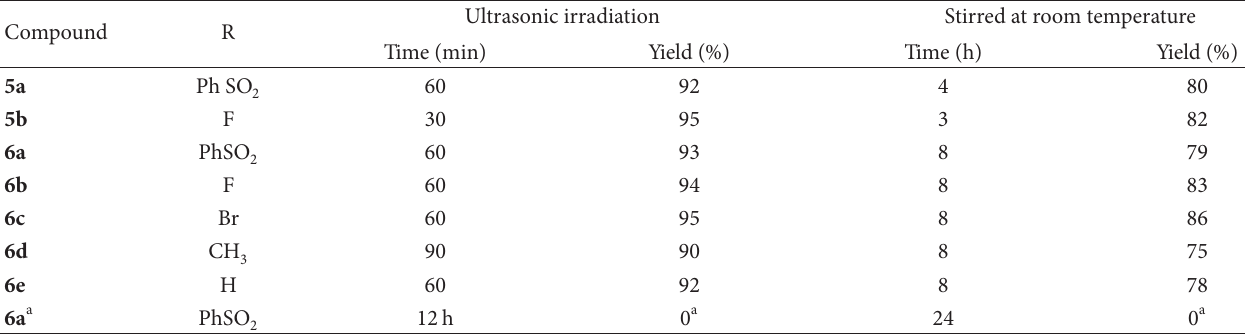
T 2: Synthesis of 2-bromo-1-substituted ethanones 5a,b by bromination, and 1-substituted 2-(phenylsulfonyl) ethanones 6a–e by CuI catalyzed sulfonation as outlined in Scheme 3.